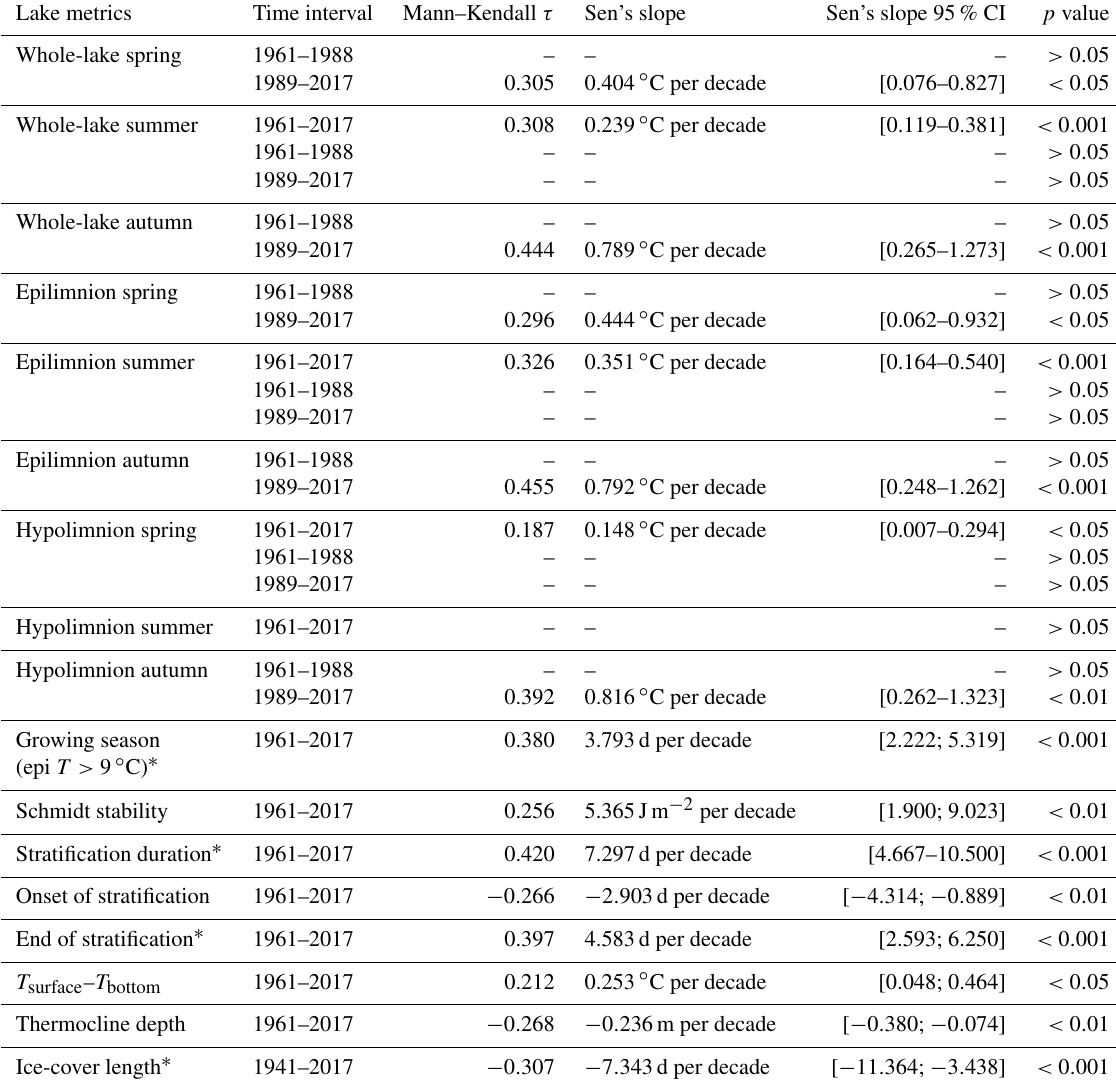
Table 4. Trend analysis results of the investigated lake